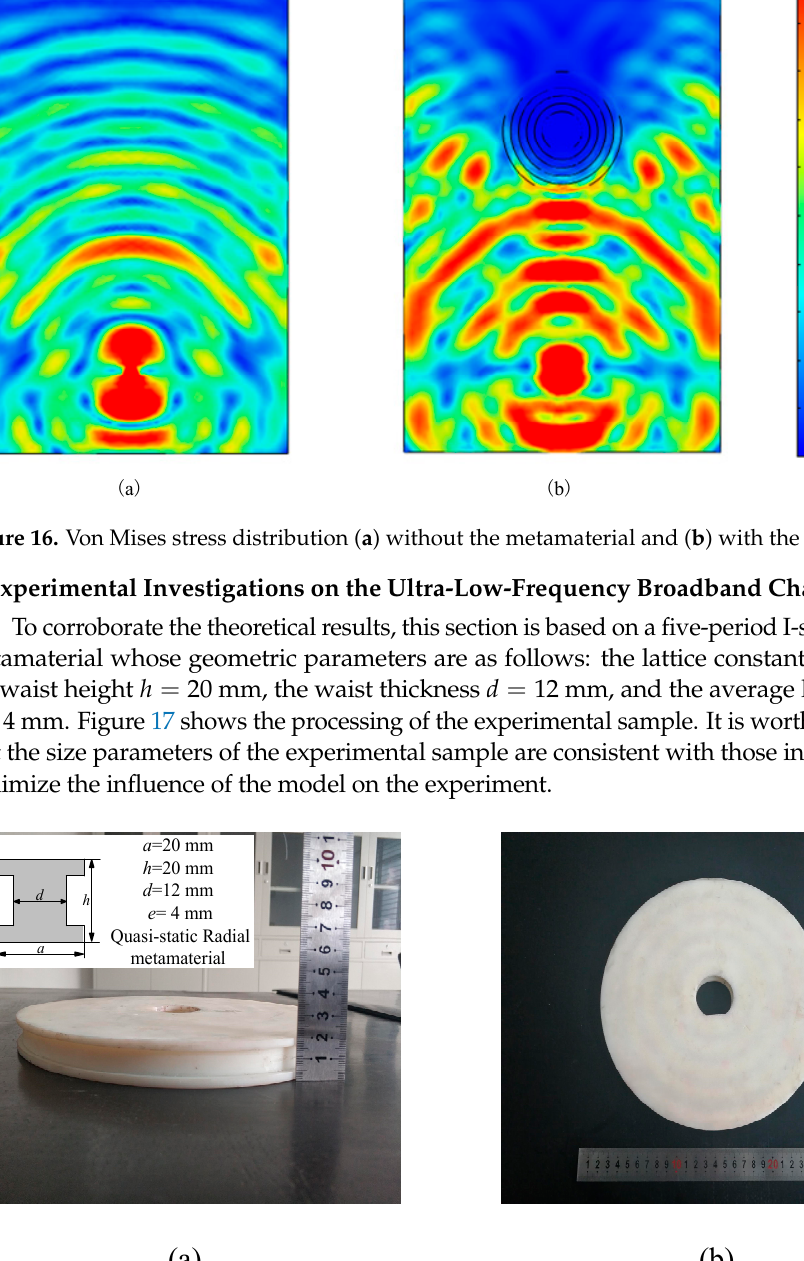
Figure 15. 580 Hz, 21-cycle excitation signal response. ( a ) Time–history curve of response signal and ( b ) Fourier spectrum of response signal.